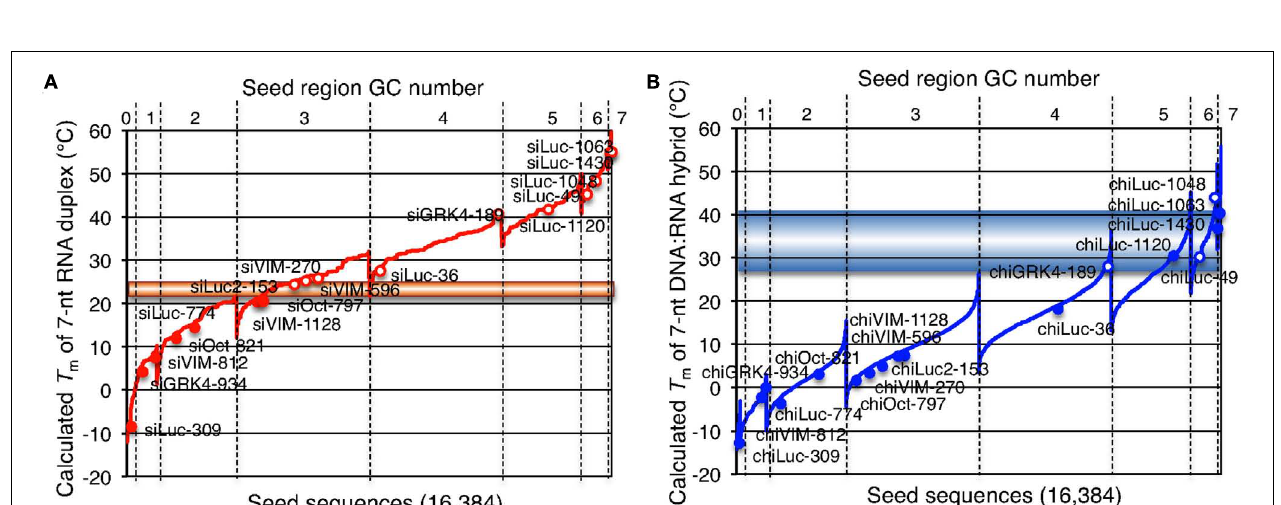
and T m values of their double-stranded counterparts with RNA (A) and DNA (B) . Note that because of its definition, class I siRNA or chiRNA cannot possess more than four GCs in the seed region. Open red (A) or blue (B) circles represent combinations of target and siRNA resulting in less than 50% relative luciferase activity. Solid red (A) or blue (B) circles represent combinations of target and siRNA with little or no off-target effect (luciferase activity > 50%).The horizontal line at 21–25˚C (A) or 28–41˚C (B) may correspond to 50% luciferase activity